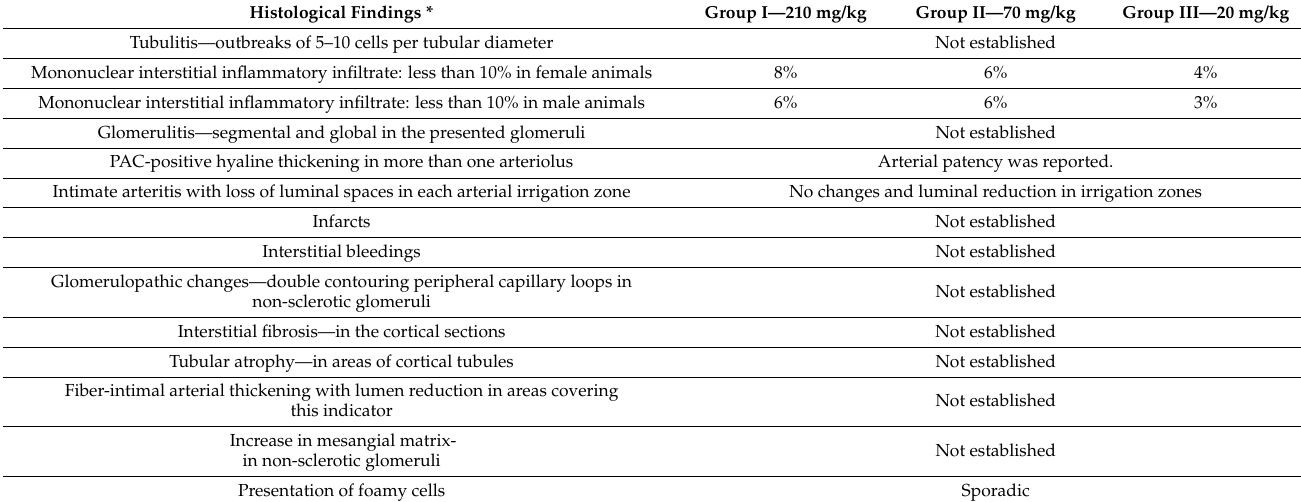
Table 6. Histological findings in kidney tissue specimens of female and male mice with EtOAc-AP extract of G. urbanum administrated orally for 14